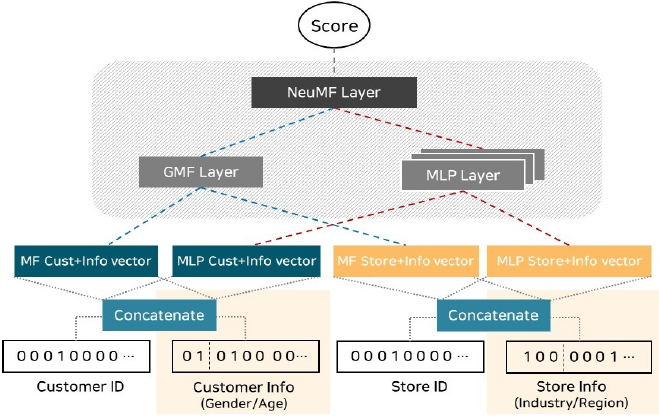
Figure 6. Structure of NMF with Customer and Store Information (NMF_CSI).